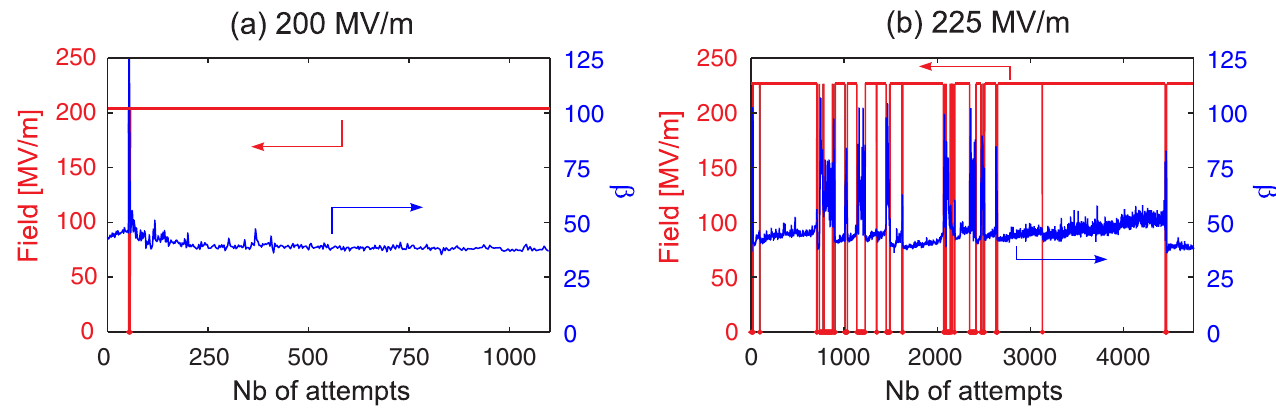
FIG. 7. (Color) Evolution of (cid:1) during breakdown rate measurements: (a) at 200 MV = m ( BDR ¼ 4 (cid:1) 10 (cid:2) 3 ); (b) at 225 MV = m ( BDR ¼ 0 : 11 ). The electric field is in red, (cid:1) in blue. The electric field is plotted at zero if a breakdown occurs, at the working value